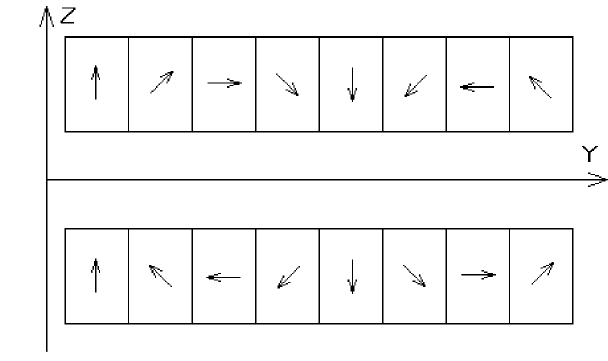
FIG. 2. Eight-blocks per period wiggler